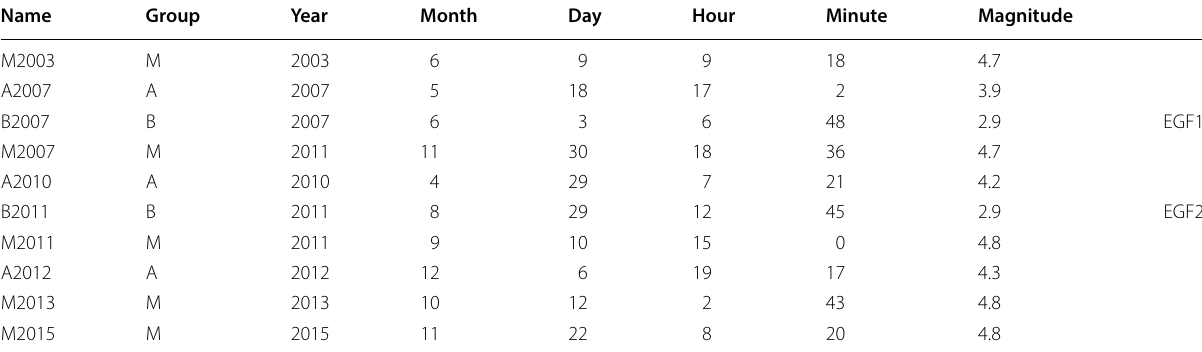
Table 2 Naka‑Oki earthquakes